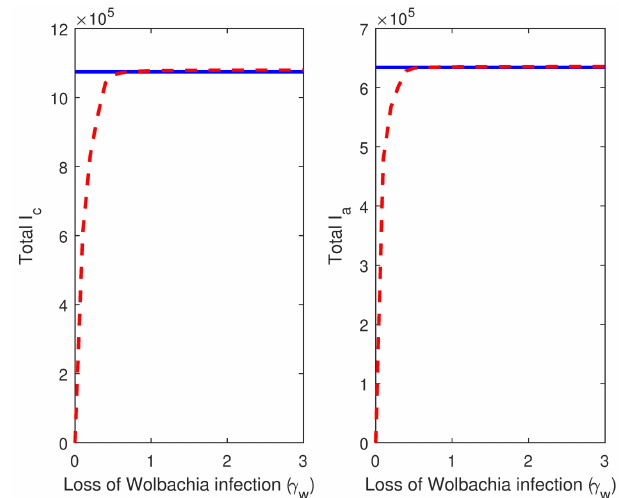
Figure 6. Simulation of the total infection at the end of week 156 when varying the rate of loss of Wolbachia infection (week − 1 ) in comparison with infection in the absence of Wolbachia . We use the WAu parameter values.